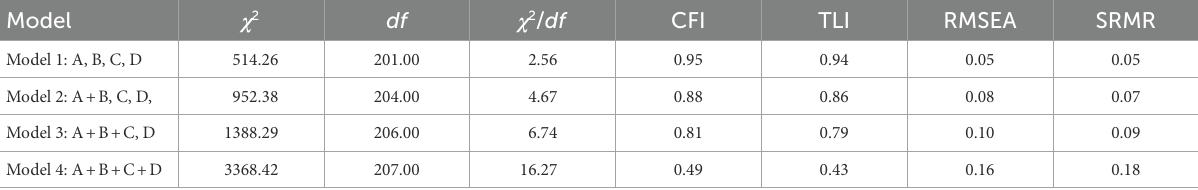
TABLE 1 Results of the confirmatory factor analysis. Model